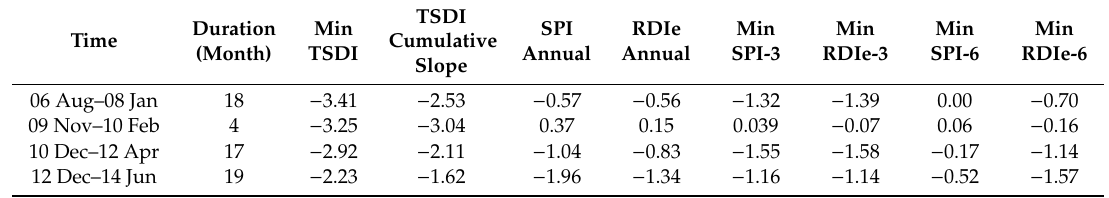
Table 7. The severity and duration of droughts in the arid zone of the studied area.